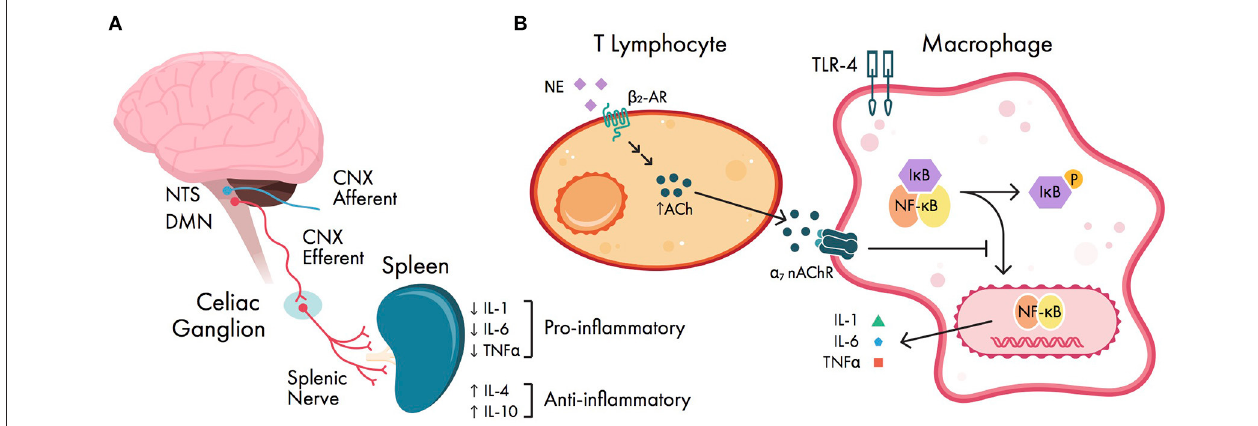
FIGURE 3 | Cholinergic anti-inflammatory pathway. (A) schema of vagal reflex arc. Damage-associated molecular patterns (DAMPs) are sensed by vagal afferents; the efferent vagal arc terminates in the celiac ganglion onto splenic nerve fibers, ultimately causing downregulation of pro-inflammatory cytokines and upregulation of anti-inflammatory cytokines. (B) cellular signaling within the cholinergic anti-inflammatory pathway. Splenic nerve endings terminate near T lymphocytes and increase acetylcholine (ACh) production via β 2 adrenergic receptors ( β 2 -ARs). The expressed ACh can activate circulating macrophages via alpha-7 nicotinic ACh receptors ( α 7 nAChRs). Activation of α 7 nAChRs causes downstream inhibition of NF-kB activation, ultimately decreasing pro-inflammatory cytokine release. CNX, cranial nerve X (vagus nerve); DMN, dorsal motor nucleus of the vagus; IL, interleukin; NE, norepinephrine; NTS, nucleus tractus solitarius; P, phosphate group; TLR-4, Toll-like receptor 4; TNF α , tumor necrosis factor